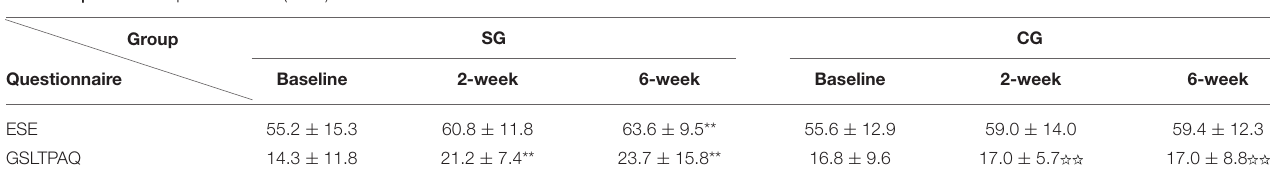
TABLE 2 | Results of questionnaires ( x ± s